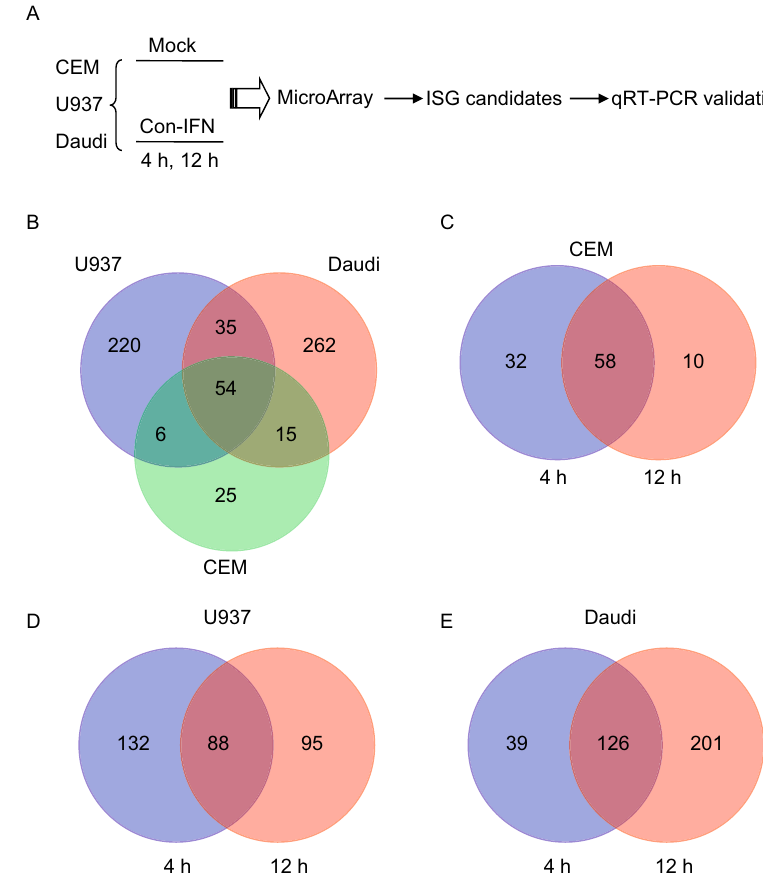
Figure 1. Identi fi cation of ISG candidates by microarray analysis. (A) Flowchart of the identi fi cation of ISG candidates. CEM, U937 and Daudi cells were mock treated, or treated with Con-IFN for 4 h or 12 h. The RNAs were isolated and reverse transcribed into cDNAs, followed by microarray analyses. Those up-regulated more than 3-fold in any cell lines with either 4 h or 12 h treatment were considered as ISG candidates and subjected to validation by qRT-PCR. (B) ISG candidates speci fi c and common in CEM, U937 and Daudi cells were categorized and represented in a Venn diagram. (C – E) ISG candidates in CEM (C), U937 (D) and Daudi cells (E) that were up-regulated more than 3-fold upon treatment with Con-IFN for 4 h or 12 h were categorized and represented in